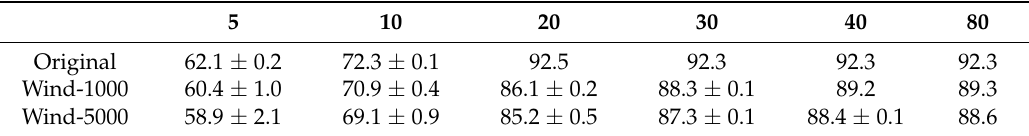
Table 1. The impact of the number of selected features to the detection accuracy. The first row indicates the quantity of features we selected from our three datasets.